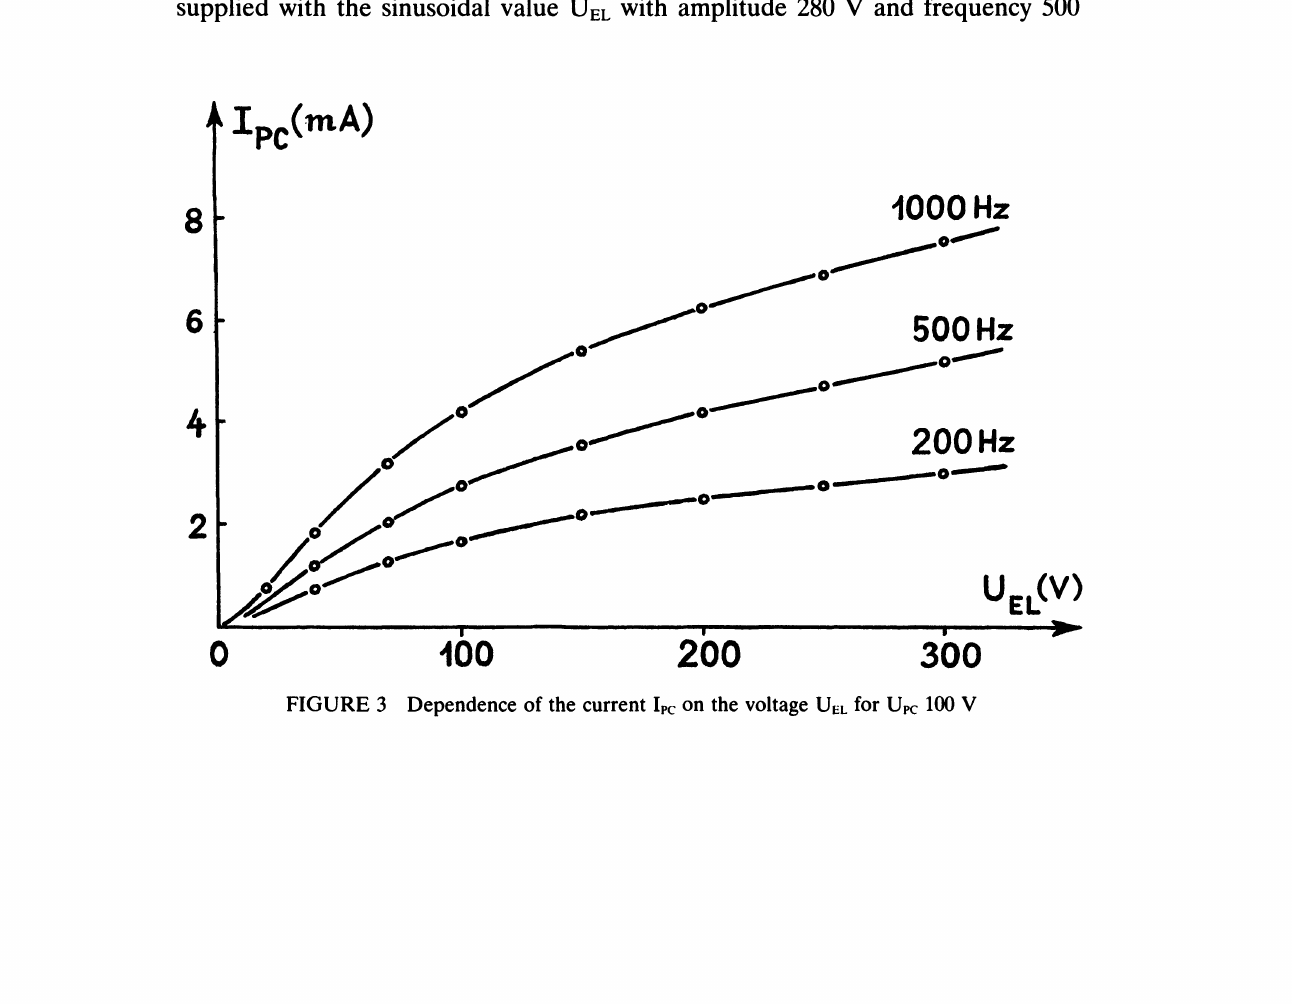
FIGURE 3 Dependence of the current Ipc on the voltage UEL for Upc 100